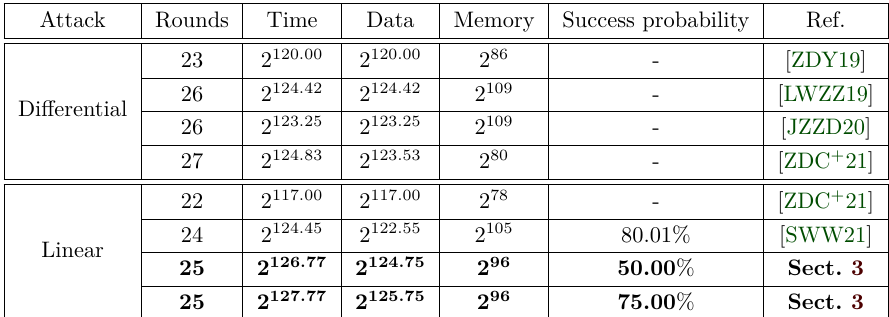
Table 1: Summary of cryptanalytic results on GIFT-128